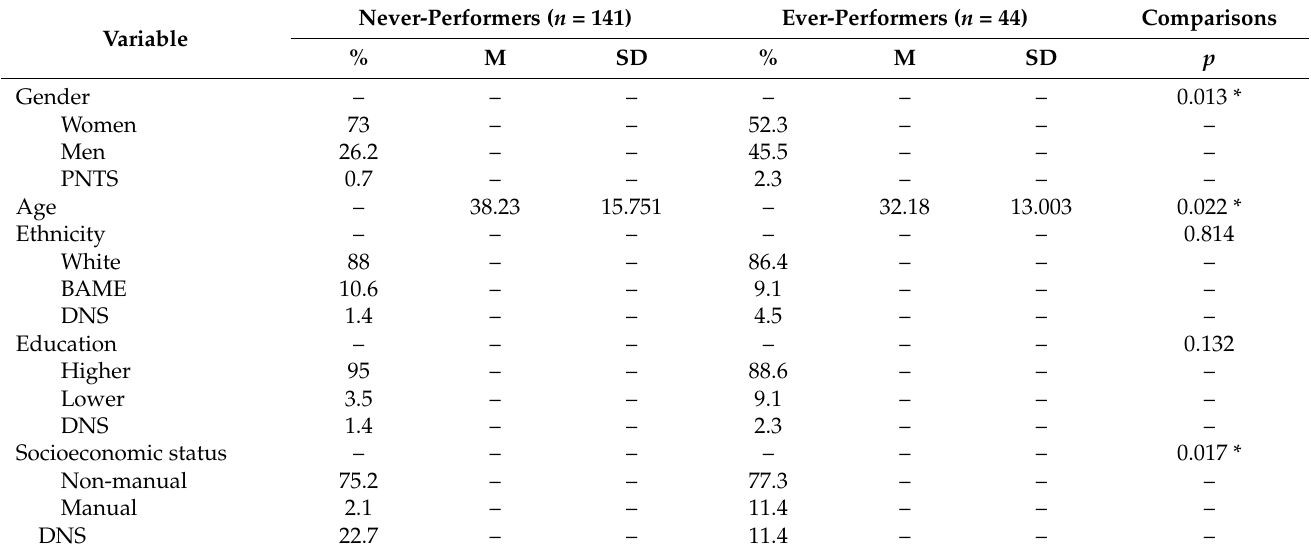
Table 1. Sociodemographic comparisons between hearing protection groups.